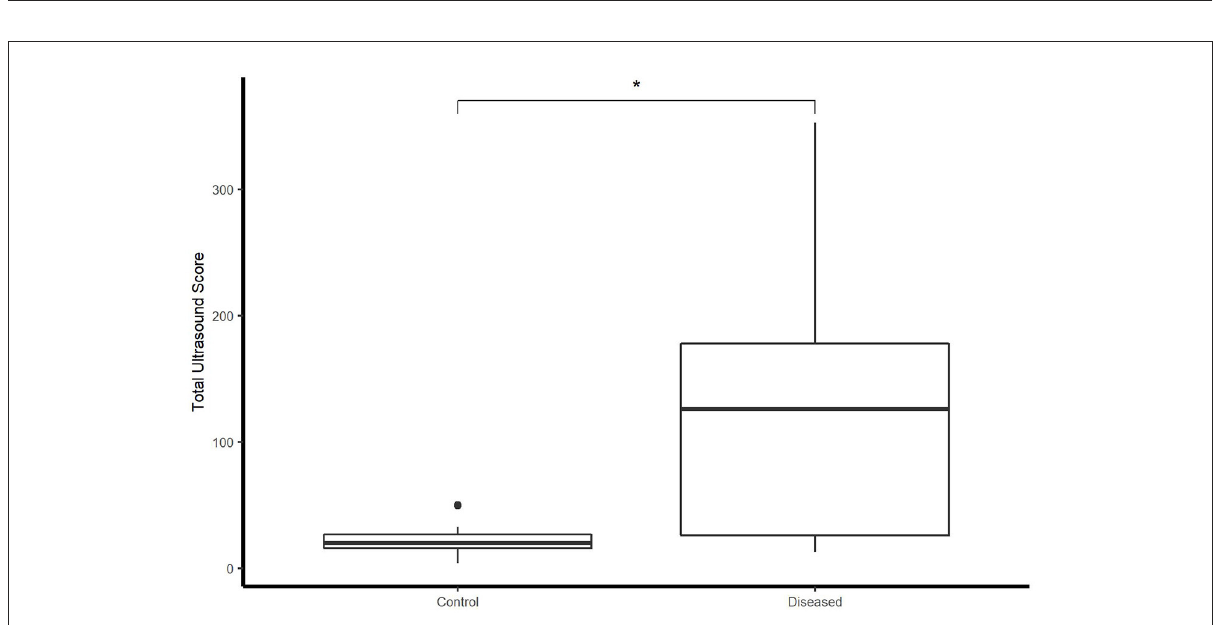
FIGURE2 Boxplot illustrating LUS score between control and diseased group. *indicates statistical significance. Significance p <